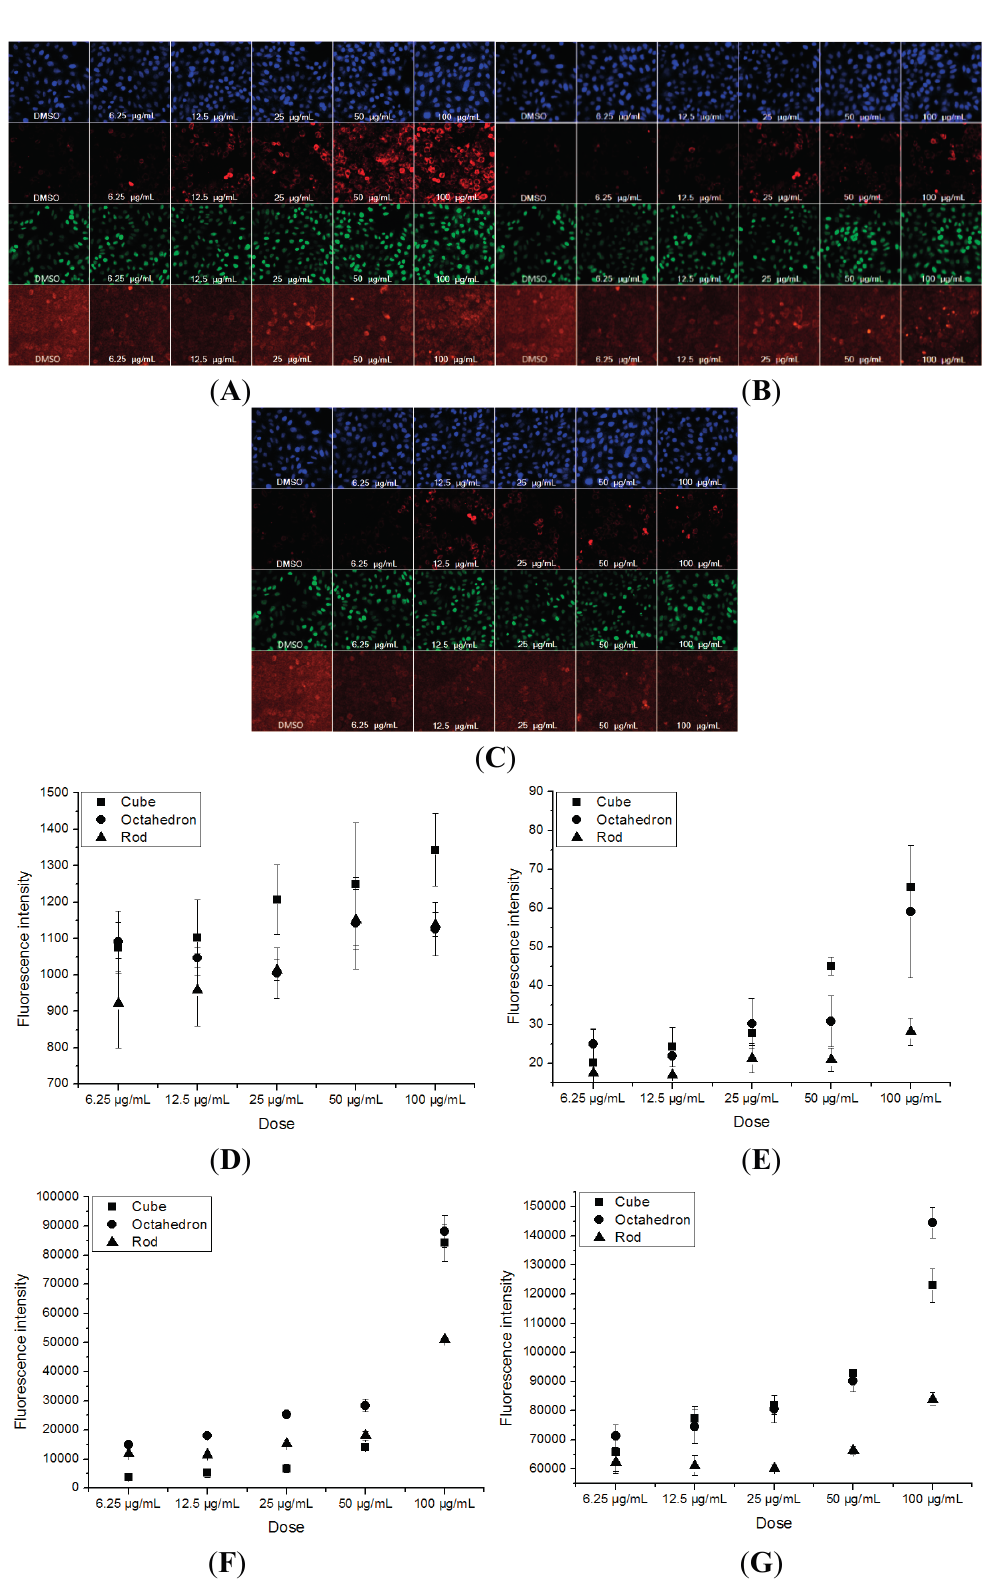
Figure 6. High-content screening of nano-CeO 2 induced hepatotoxicity. HepG2 cells were treated with cube- ( A ), octahedron- ( B ), and rod-like ( C ) nano-CeO 2 at various concentrations. The figures from top to bottom correspond to cellular images of cells count, MMP, ROS and GSH. Their normalized cellular fluorescence intensities were plotted as a function of treatment dose in cells count ( D ), MMP ( E ), ROS ( F ) and GSH ( G